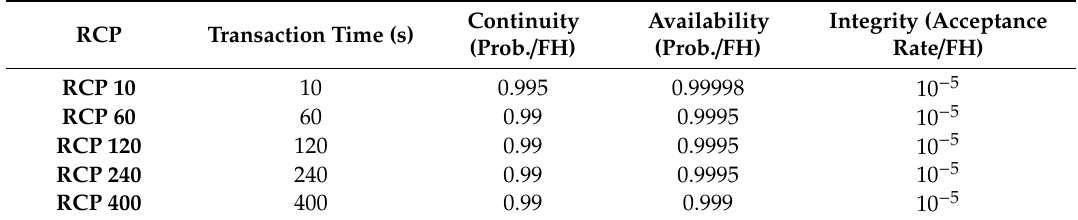
Table 1. Required communication performance (RCP) requirements